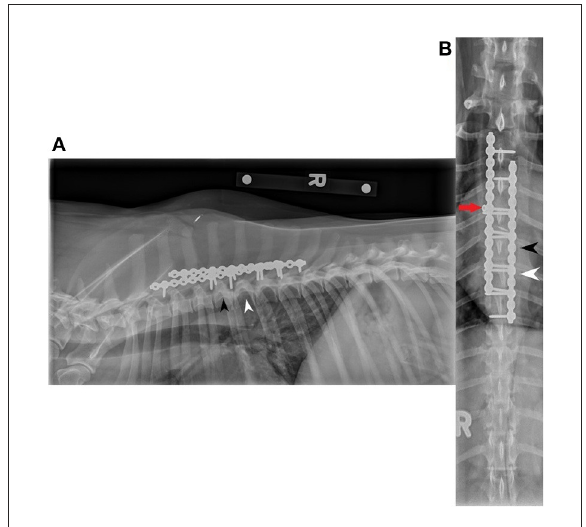
FIGURE4 Right lateral (A) and dorsoventral (B) two view recheck radiographs, taken 8 weeks postoperatively, showing the same two SOP ® dorsal locking plates as in Figure 3. The black arrowhead indicates T5, and the white arrowhead indicates T6. The red arrow indicates slight loosening of the second screw in the right plate. The screw was still engaged in the vertebra, and no evidence of inappropriate radiolucent halo was seen. No other screws showed evidence of migration and the apparatus was still deemed